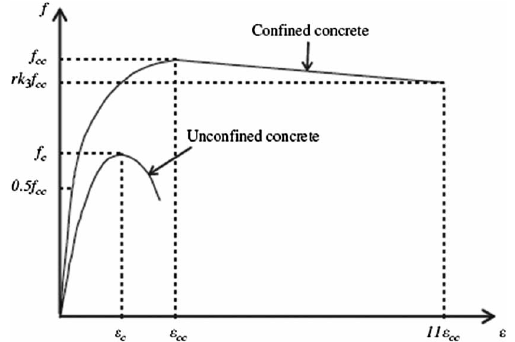
Fig. 3. Equivalent uniaxial stress (cid:1) strain curves for concrete (Ellobody, Young